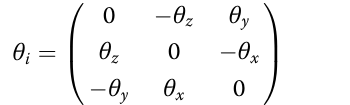
Fig. 3a. The available RLVs can be expressed as ! ! ! ! ð 3 Þ ¼ lG þ mG þ nG G lmn 100 010 001 ! ! where l , m , and n are integral numbers. G ! 100 , G 010 , and G 001 represent different RLVs, where the vector direc- tions are along the x -axis, y -axis, and z -axis, respectively.